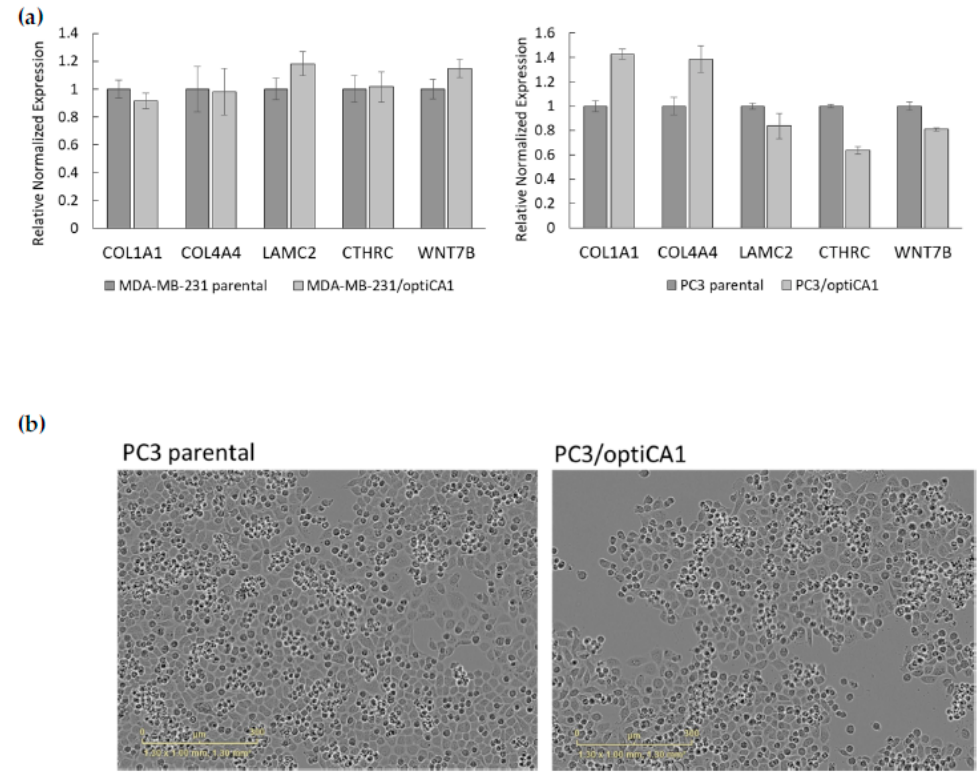
Figure 1. Genetically engineered tumor cells MDA-MB-231 and PC3 stable overexpress codon optimized human CA1 gene (optiCA1). ( a ) Structure of provirus ST44optiCA1. LTR, long terminal repeat; IRES, internal ribosomal entry site; psi + , packaging signal; neo, neomycin resistance gene; optiCA1, optiCA1 gene subcloned from pSF-CMV-CA1 plasmid (Oxford Genetics). ( b ) Detection of integrated provirus ST44optiCA1 in genomic DNA of tumor cells by PCR; vector specific psi + sense primer and optiCA1